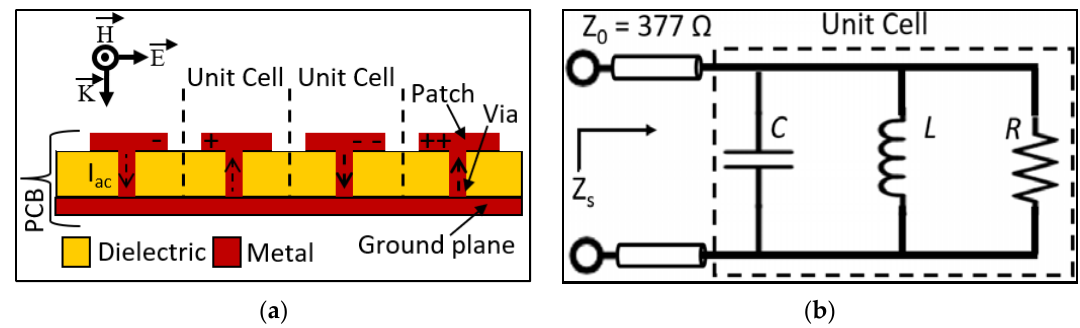
Figure 1. MS reflector structure and basic unit cell model: ( a ) side view of the MS structure interacting with a plane wave and ( b ) MS unit cell equivalent circuit model.